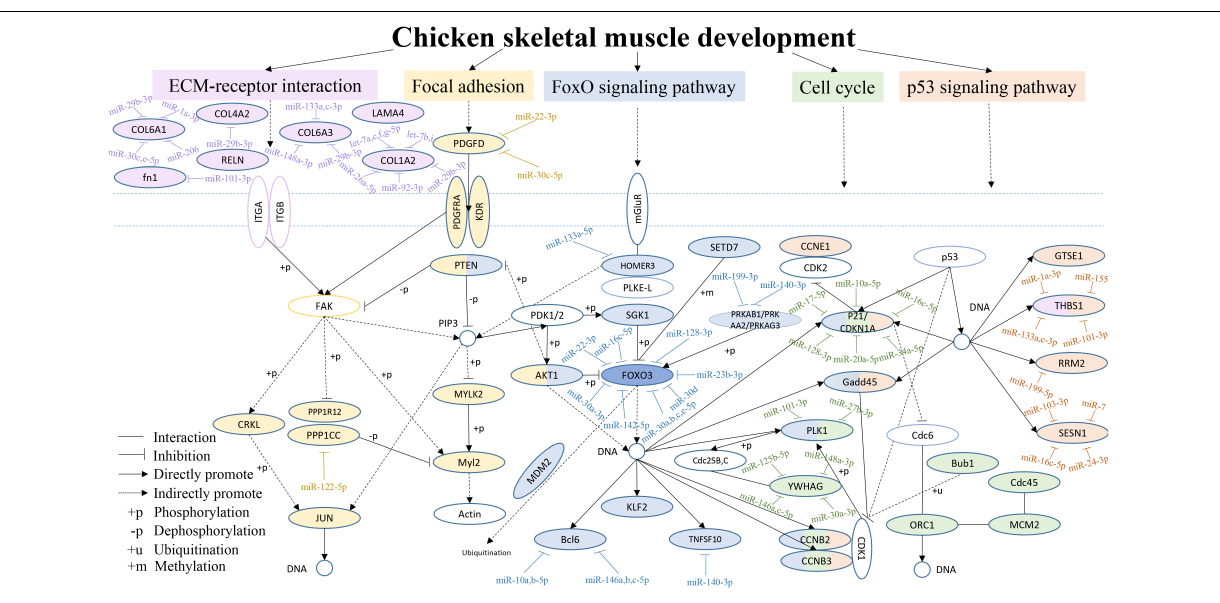
The PPI network from DEGs of the W22 vs. W6 comparison contained 27 protein–protein pairs. Thereinto, ND6-ND2 were up-regulated, and the other 26 pairs such as CDK1 - PLK1 ,